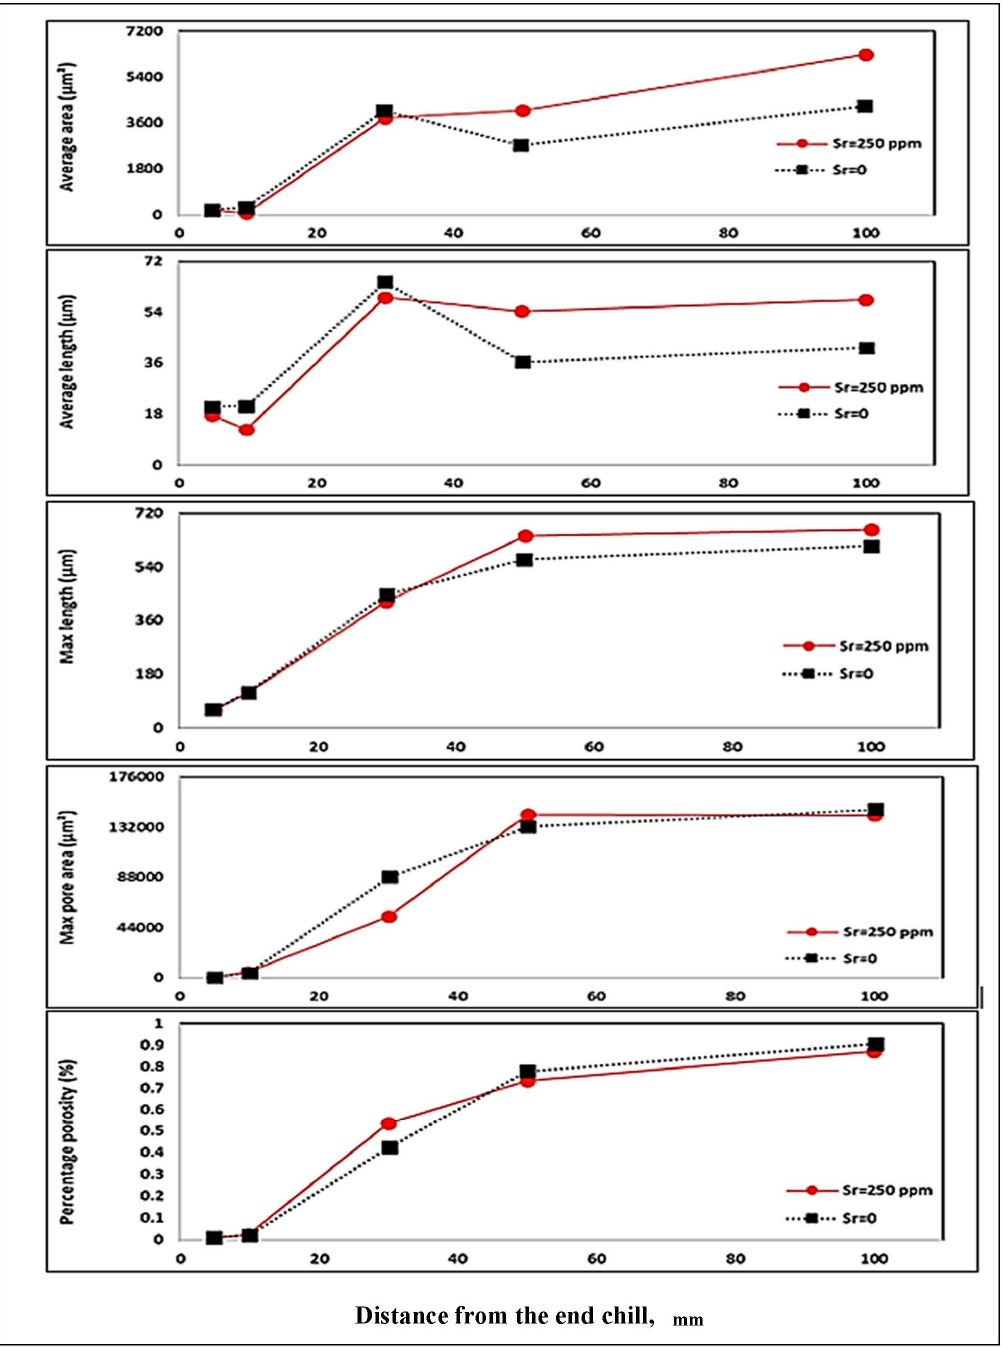
Figure 17. Porosity distribution in 319 alloy containing (H = 0.1 mL/100 g Al, Sr = 250 ppm, Ti = 0.2%) as a function of distance from the chill end.